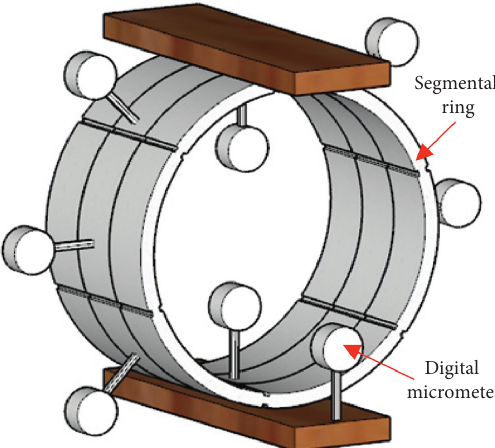
Figure 11: Arrangement of the measurement